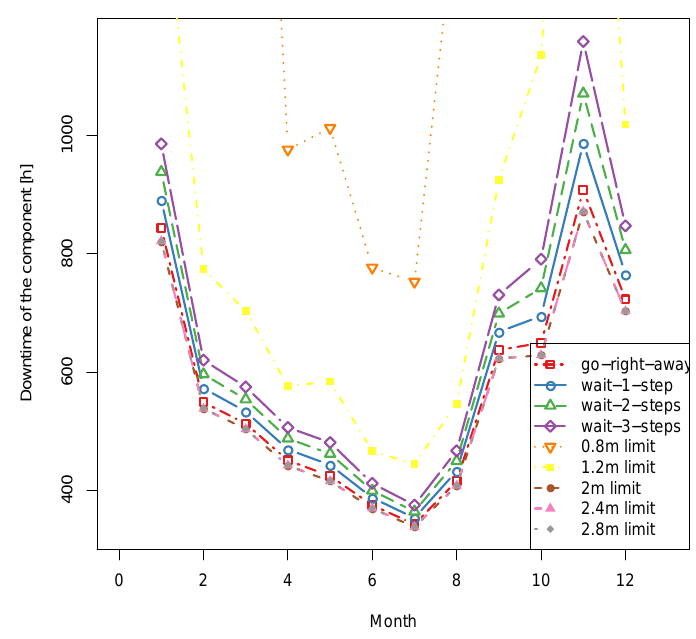
Figure 6. Downtime of the wind turbine due to a major gearbox replacement for different policies. Policies with a less restrictive wave height threshold for the vessel access have a lower downtime than more restrictive